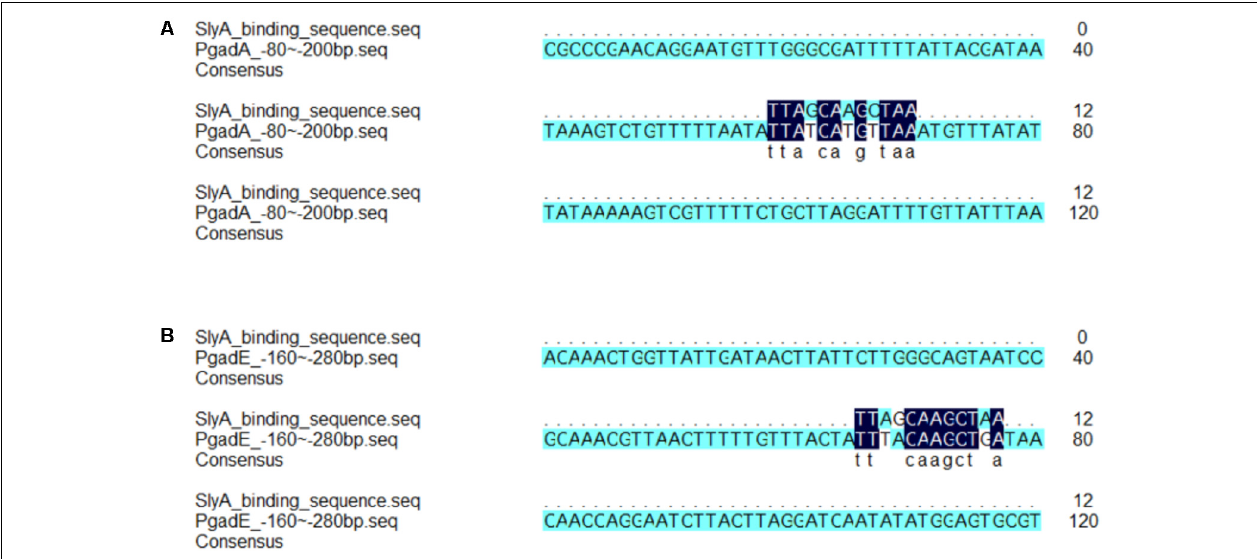
FIGURE 5 | Alignment analyses revealed consensus SlyA-binding sequence in the promoter regions of the gadA and gadE genes. The alignment of consensus SlyA-binding sequence and fragments of the promoter of gadA (A) and gadE (B) was performed by the DNAMAN software.